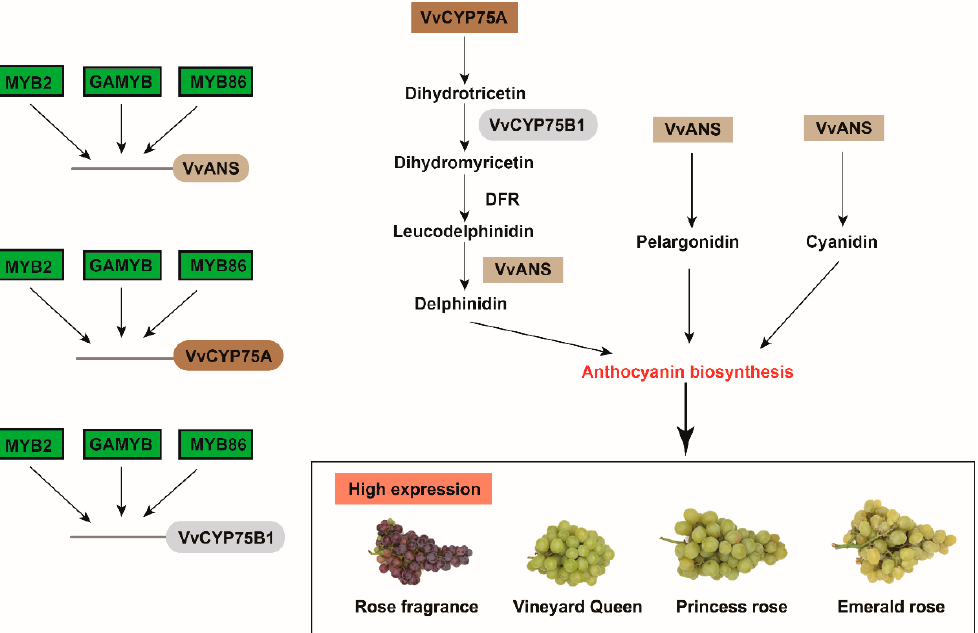
Figure 7. General mechanism of anthocyanin biosynthesis. Solid lines between MYB2, GAMYB, and MYB86 and the start of the gene promoter indicate that these transcription factors may be able to bind to the three genes and affect gene function. The solid line on the right shows the order in which the genes influence each other; the ultimate goal is to influence the phenotype of grapes by affecting anthocyanin